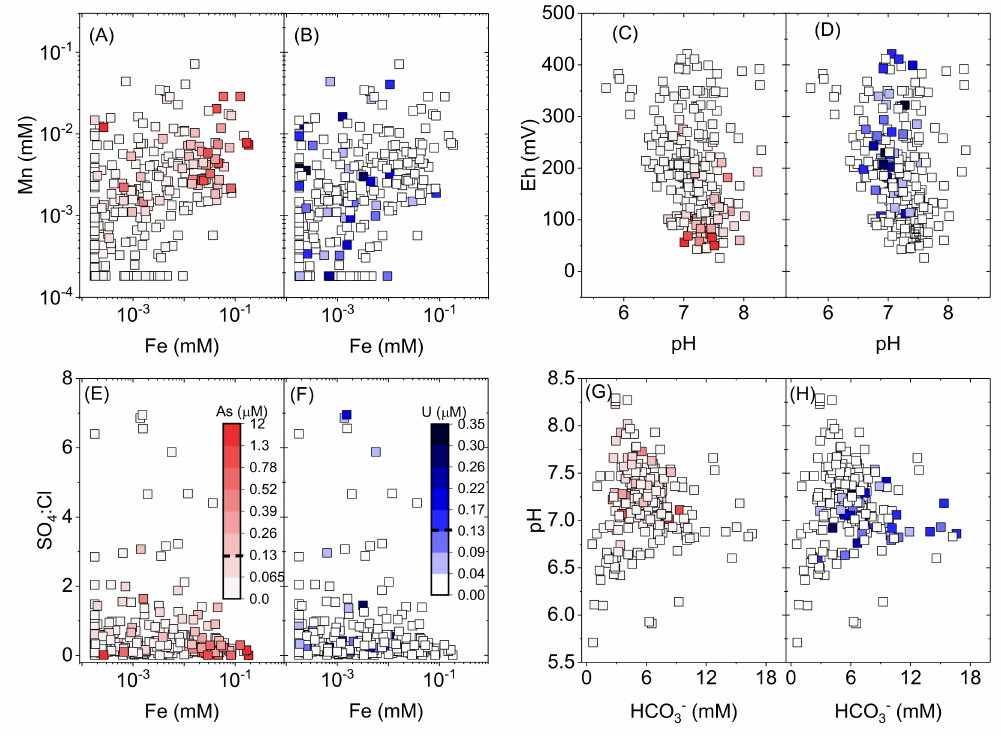
Figure 13. Bivariate plots for ( A , B ) Mn versus Fe; ( C , D ) Eh versus pH; ( E , F ) SO 4 2 − :Cl − (molar ratio) versus Fe; and ( G , H ) pH versus estimated HCO 3 − . Red colour scales ( A , C , E , G ) represent As concentrations, and blue colour scales ( B , D , F , H ) represent U concentrations. Samples with measured concentrations below detection for a particular analyte are shown as maximum concentration at method detection